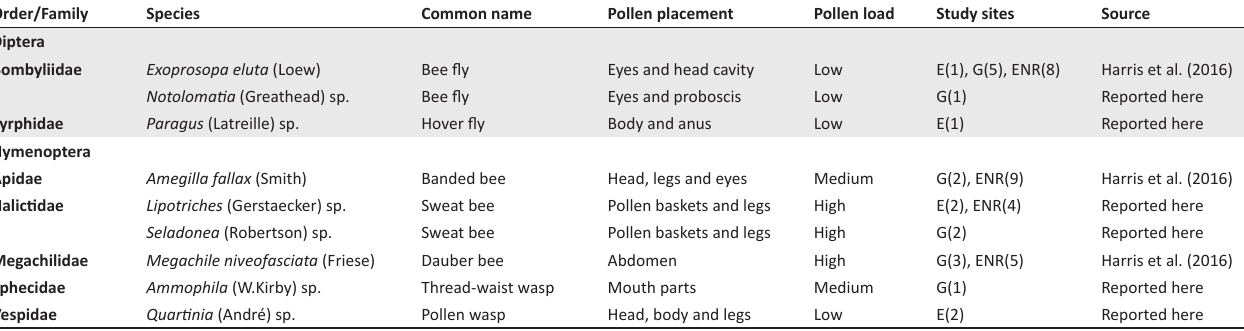
TABLE 2: Frithia humilis pollen carriers with collection locality and pollen load.